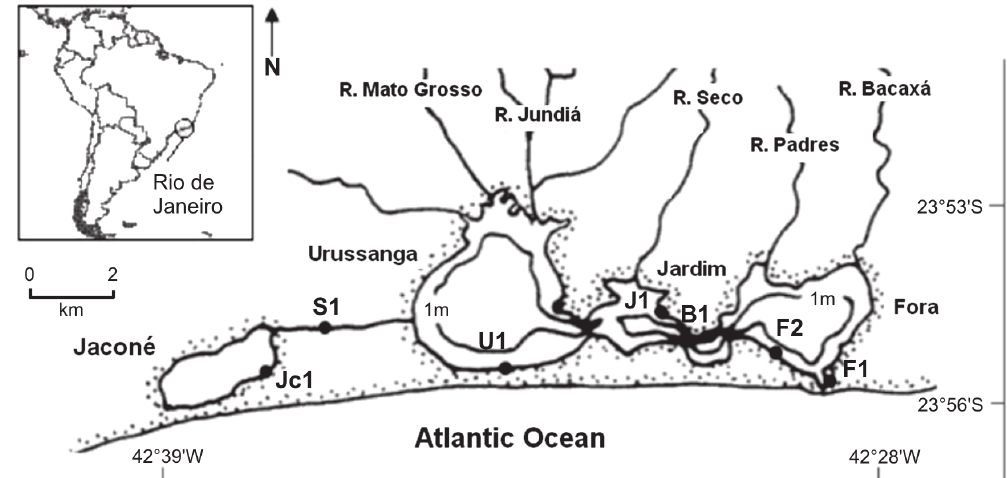
Figure 1. Location of sampling sites in Saquarema-Jaconé lagoonal